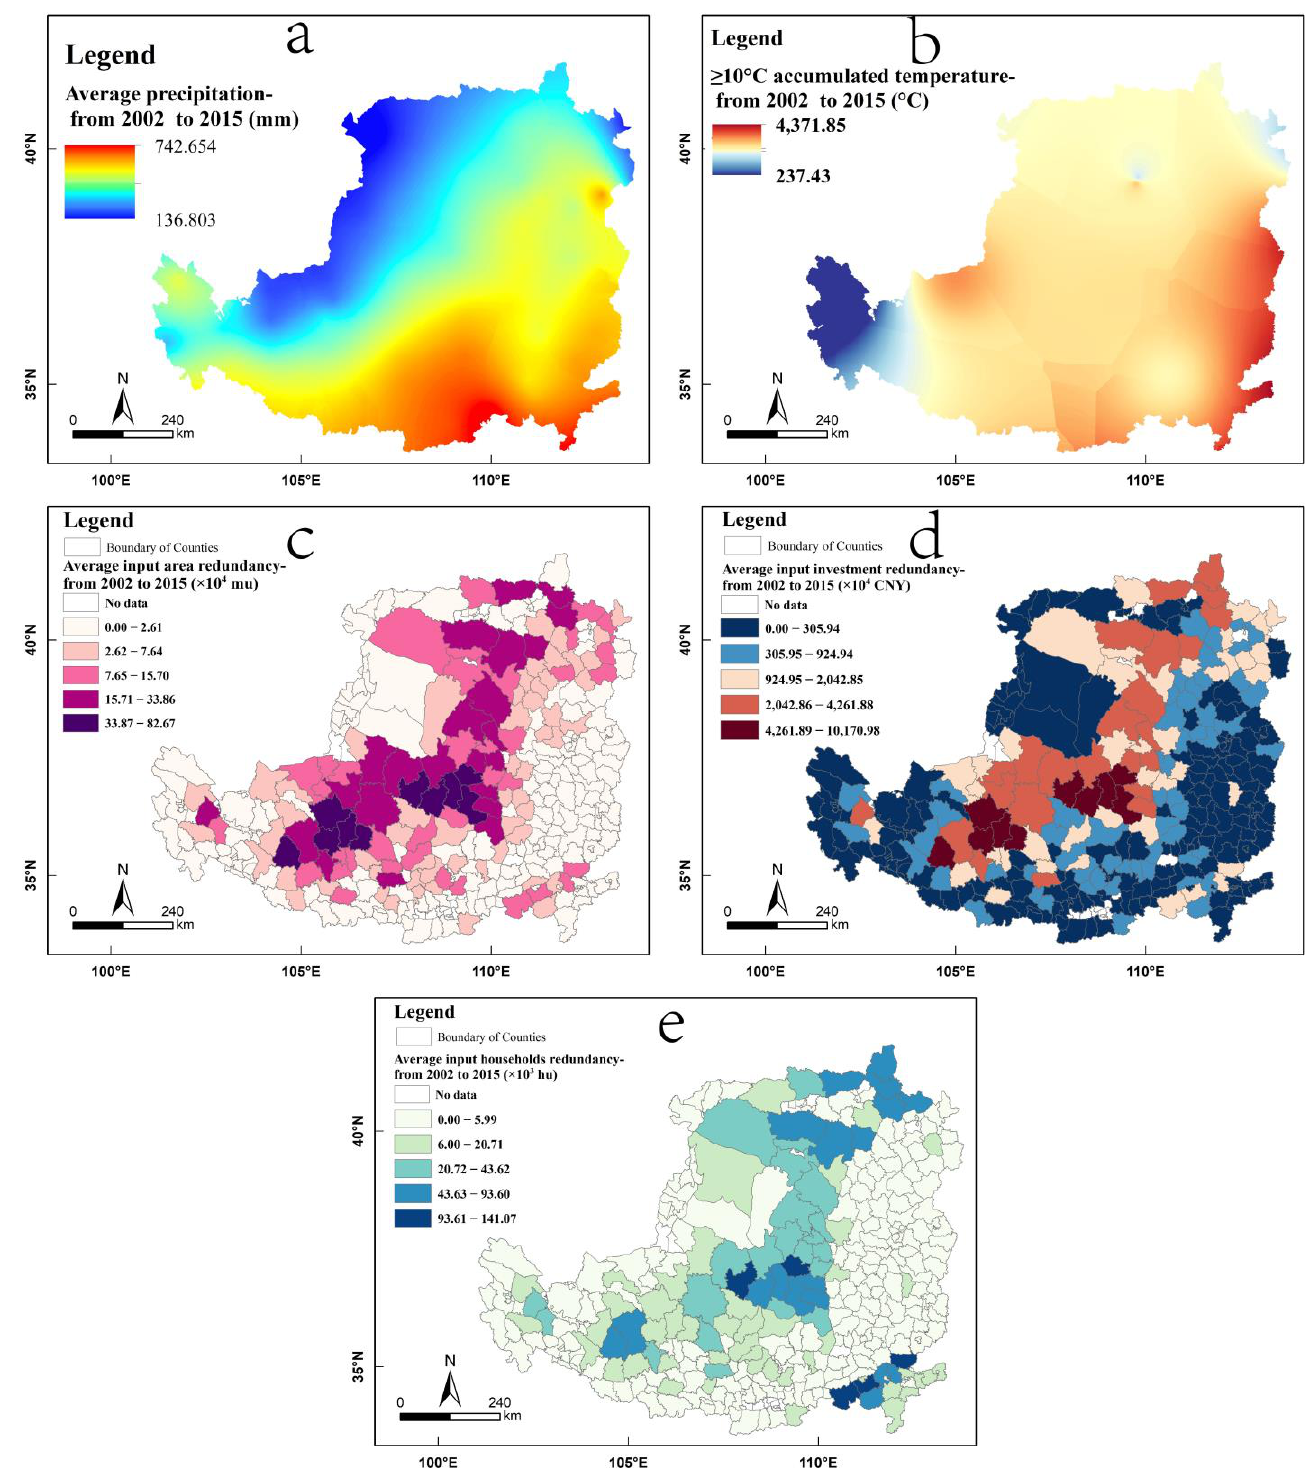
Figure A3. ( a ) Average precipitation; ( b ) average ≥ 10 ◦ C accumulated temperature; ( c ) average input area redundancy; ( d ) average input investment redundancy; ( e ) average input households participating redundancy, 2000 to 2015.